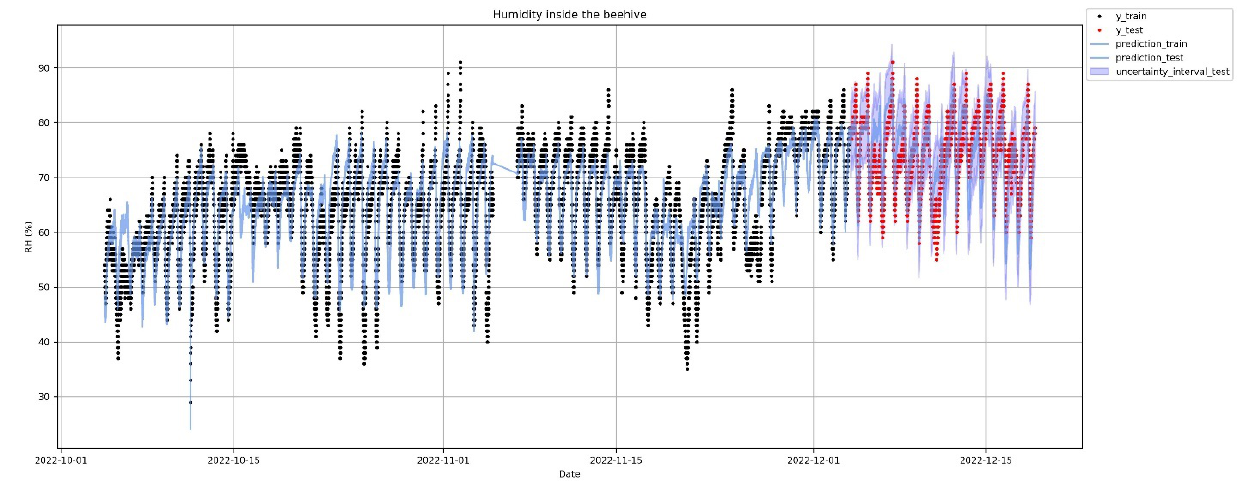
Figure 15. Prediction of humidity inside the hive on the whole dataset. Prediction starts after '04– December–2022'. In red, the actual values and in blue the prediction and the uncertainty intervals.